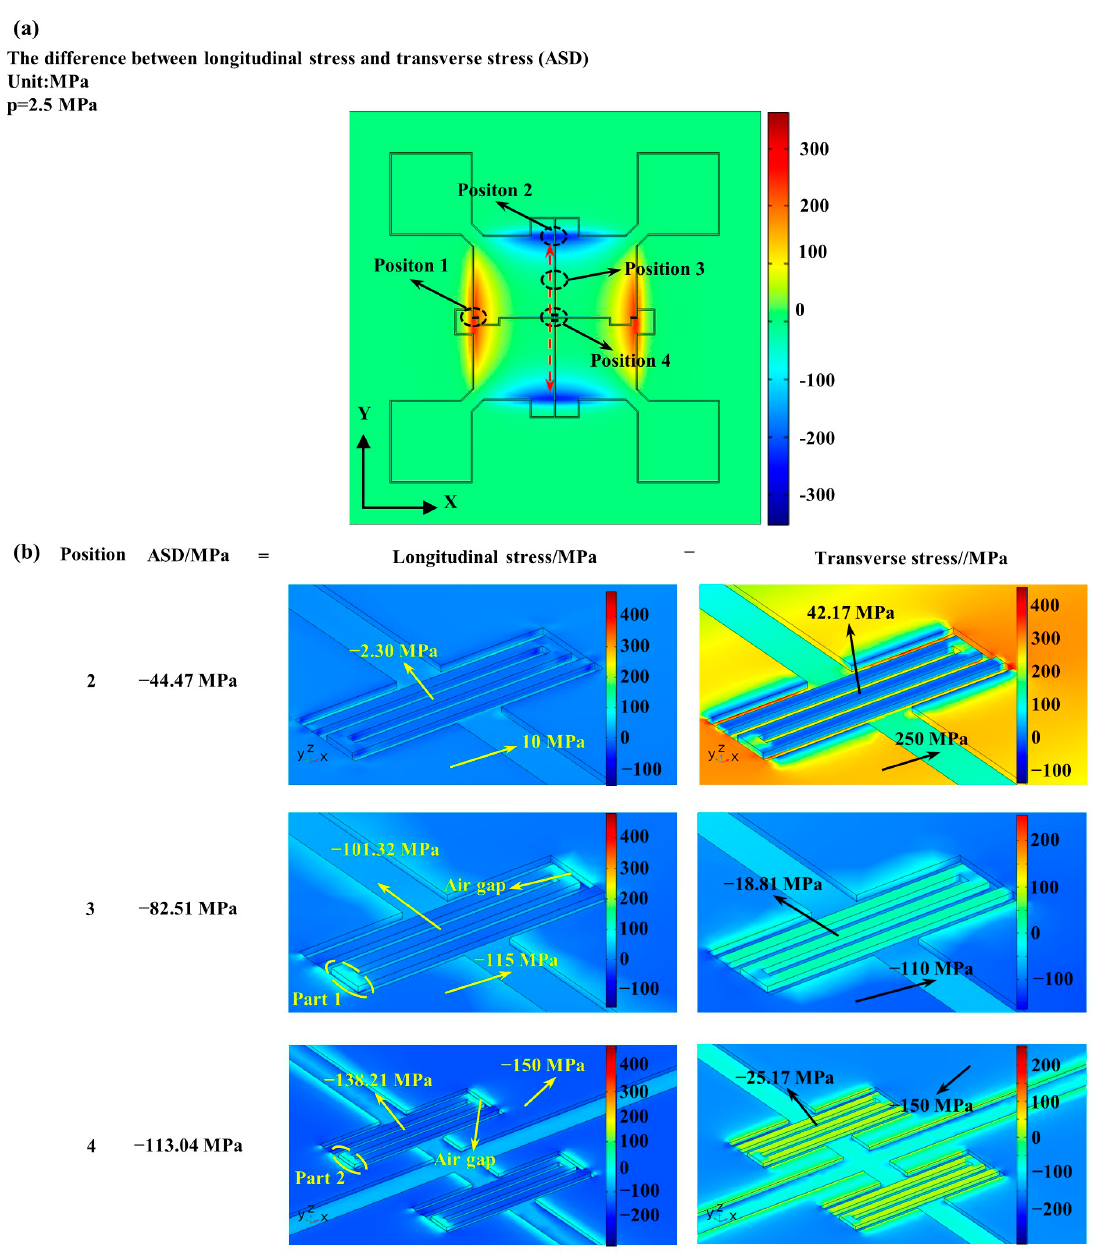
Figure 2. Numerical simulation of the surface stresses of the developed piezoresistive pressure sensor: ( a ) the absolute stress difference (ASD) of the proposed sensor with ( b ) the detailed distribution of longitudinal/transverse stresses inside the piezoresistors at positions 2, 3 and 4.